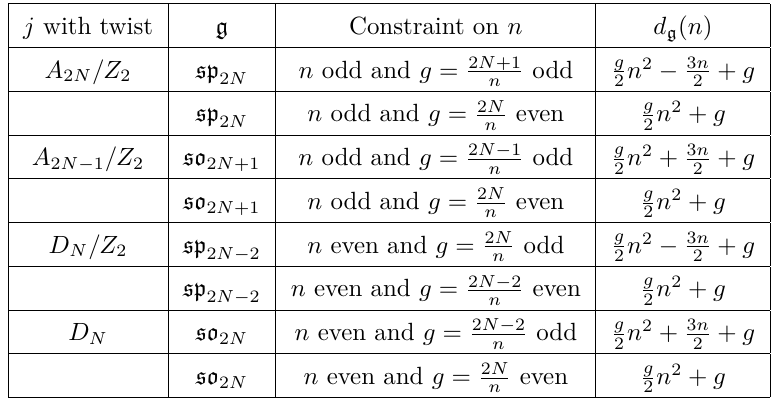
Data required to compute the growth function G of VOA V − h ∨ + n G = dim( g ) − d g ( n ) u